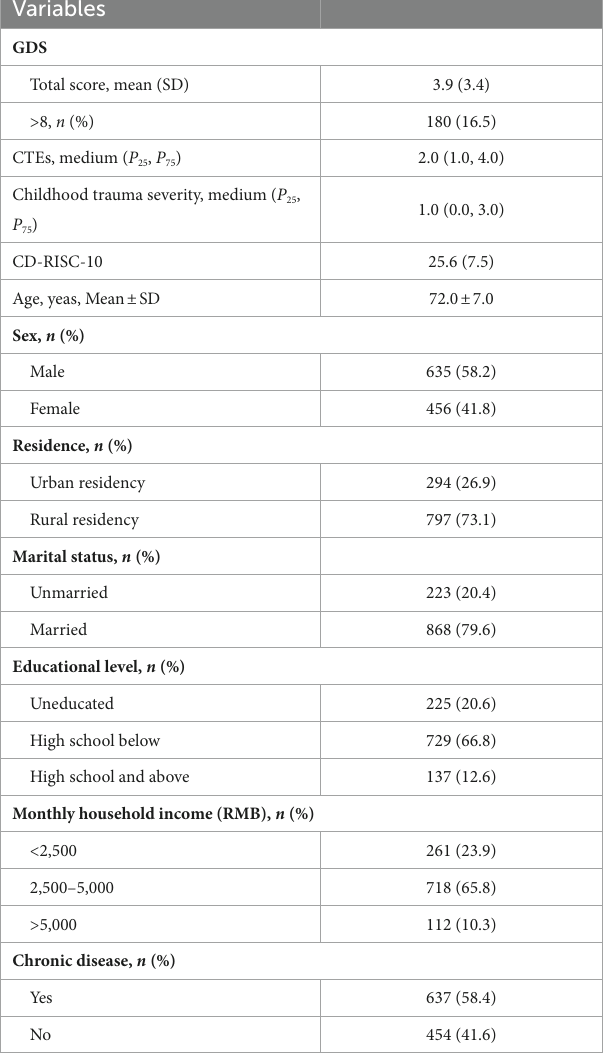
TABLE 1 Characteristics of the study sample ( N = 1,091). TABLE 2 Correlation analysis for childhood trauma, resilience, and geriatric depressive